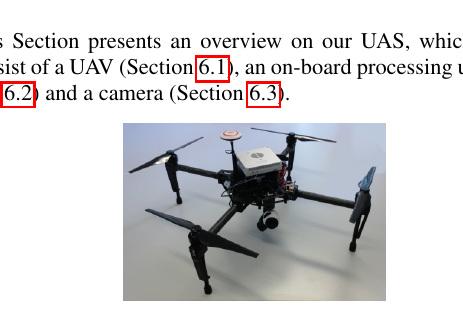
Figure 5. DJI Matrice 100 with on-board processing unit DJI Manifold and camera Zenmuse